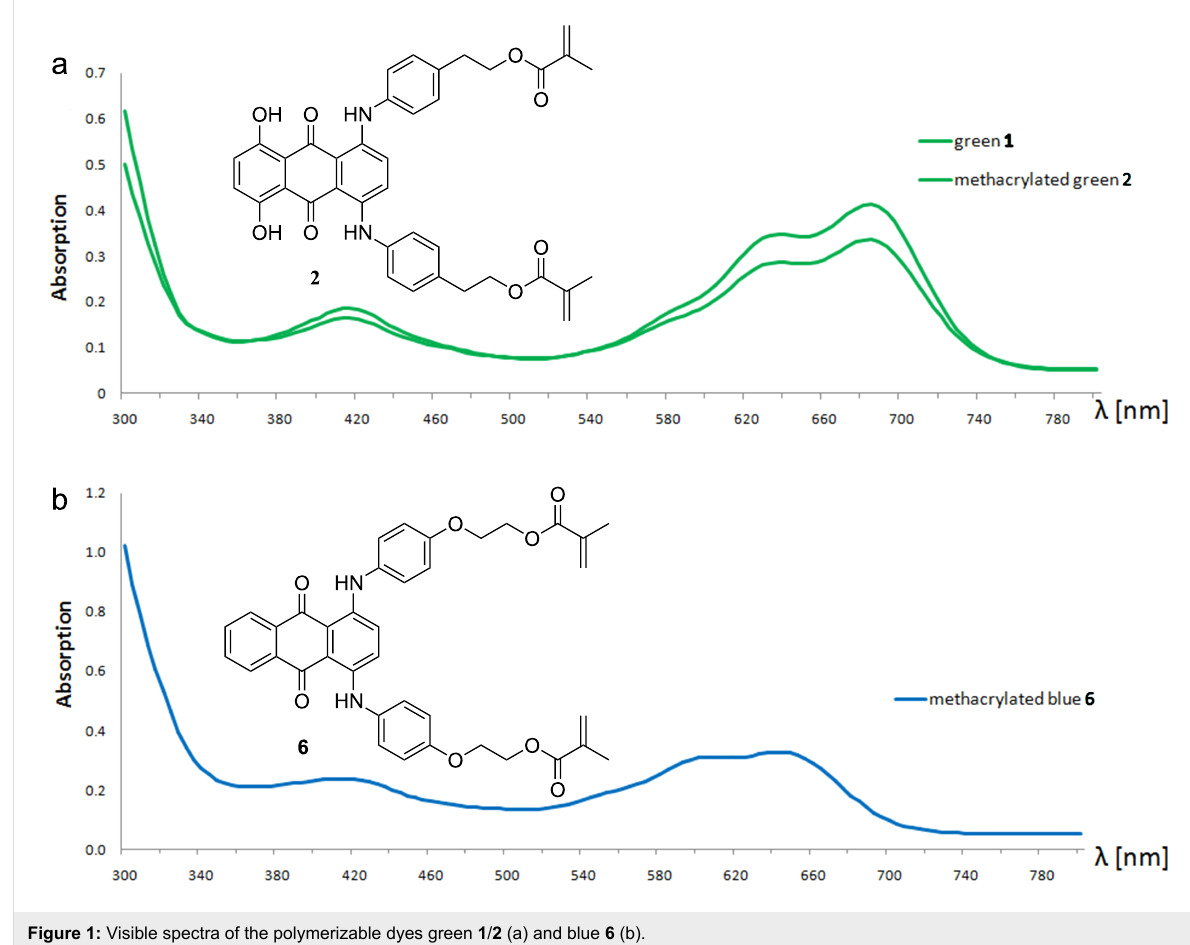
Figure 1: Visible spectra of the polymerizable dyes green 1 / 2 (a) and blue 6 (b).